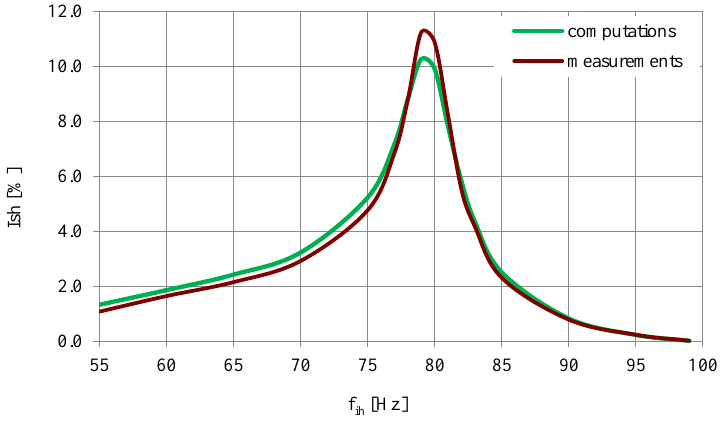
Figure 4. Measured and computed current subharmonics (related to the rated current) vs. the frequency of voltage interharmonics for motor 3-p4 and voltage containing interharmonics of value U ih = 1 % U 1 .